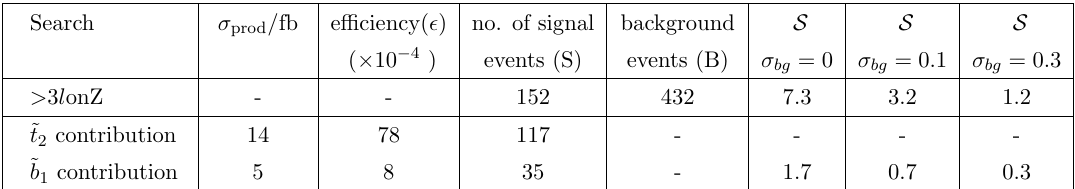
(cid:0) m ~ (cid:25) 240 GeV (red curve) and m ~ t 1 b 1